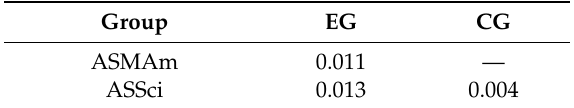
Table 3. ASMAm and ASSci, in experimental and control groups. Group EG CG ASMAm 0.011 — ASSci 0.013 0.004